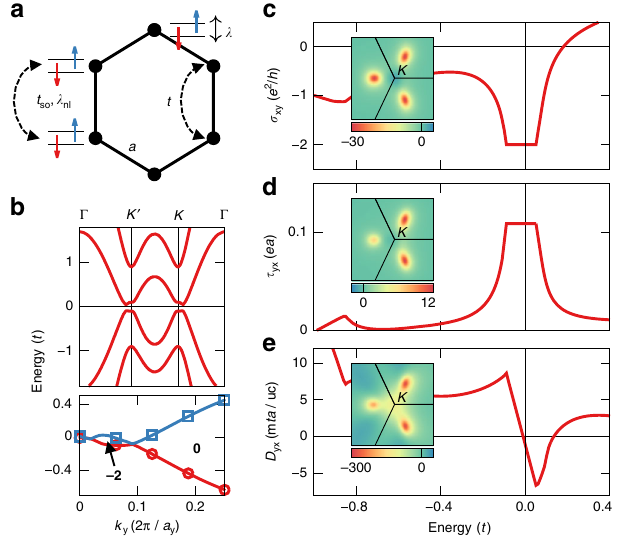
Fig. 2 Model of magnetically doped graphene. a Sketch of the tight-binding model. b Band structure with out-of-plane magnetization and t so = 0.3 t , λ = 0.1 t , and λ = 0.4 t . In addition, we show the valence band maximum nl (red circles) and conduction band minimum (blue squares) for given values of k y , where the depicted gap closing occurs for θ = 270° and ; 0 : 09 2 π k ¼ 0 : 71 2 π a a y . The bold integers denote the mixed Chern number x Z in the insulating regions, and a = 3 a /2. c – e Energy dependence of the y R Ω kk dk x dk y , the anomalous Hall conductivity σ xy ¼ C e 2 = h ¼ e 2 = ð 2 π h Þ xy torkance τ yx , and the spiralization D yx , respectively, for an out-of-plane magnetization. Insets show the corresponding momentum-space distributions summed over all occupied states in the vicinity of the K re fl ecting the change of the free energy F due to chiral pertur- (cid:6) (cid:7) P 13 . D ij ^ e i (cid:2) ^ m ´ ∂ j ^ m bations ∂ j ^ m according to F ¼ ij